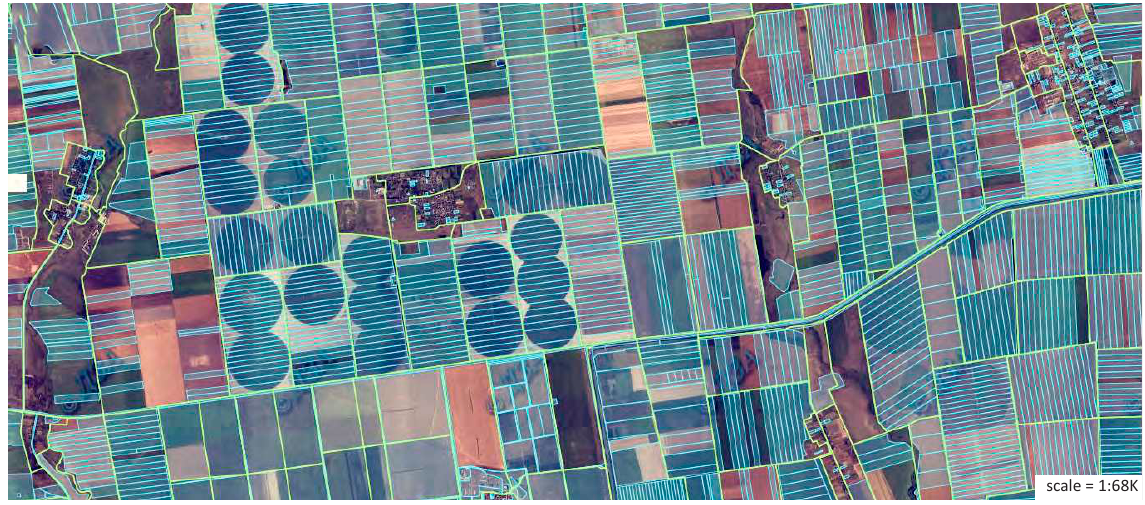
Figure 5. Cadastral map of key plot